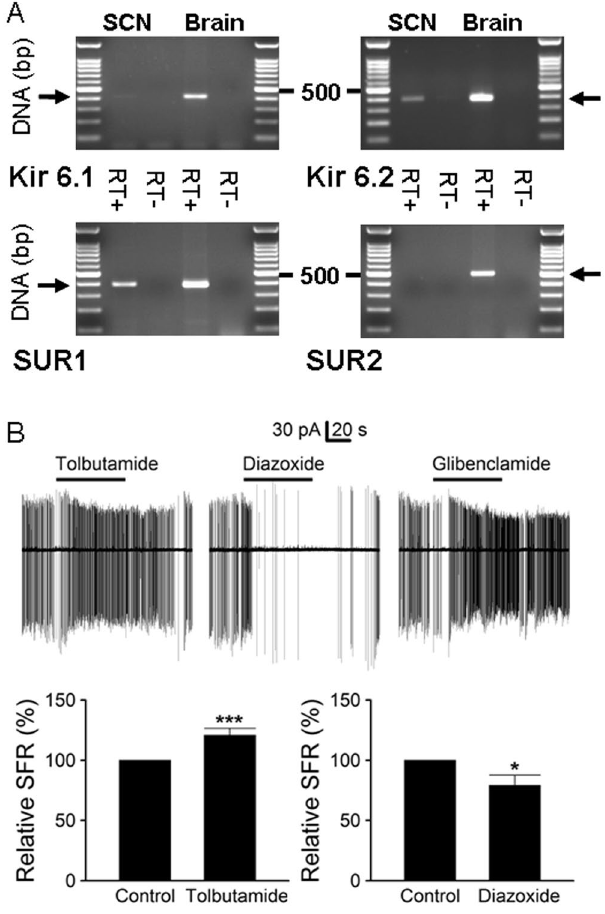
Figure 1. Kir6.2/SUR1 combination of K ATP channels in the SCN neurones. ( A ) RT-PCR analysis indicating the expression of mRNA for pore-forming Kir6.2 and sulfonylurea subunits 1 in the SCN. Positive controls were performed using cDNA from rat brain. The expected PCR product sizes for Kir6.1, Kir6.2, SUR1, and SUR2 were 411, 385, 388, and 501 bp, respectively. Negative controls were performed using RT products with omission of reverse transcriptase (RT-) to examine the contamination of genomic DNA. ( B ) Cell-attached recordings showing the effects of the sulfonylurea on spontaneous firing of the SCN neurones (ZT 4–15). Firing responses of a representative cell to 200 μ M tolbutamide (top left panel), 200 μ M diazoxide (top middle panel), and 0.1 μ M glibenclamide (top right panel). Note the lack of recovery of spontaneous firing after washout of glibenclamide. Daytime recordings (ZT 7). Bottom left panel: summary of experiments showing a moderate increase in firing rate by tolbutamide. Baseline spontaneous firing rate: 2.7 ± 0.3 Hz ( n = 50). Bottom right panel: summary of experiments showing a decrease in firing rate by diazoxide. Baseline spontaneous firing rate: 3.0 ± 0.3 Hz ( n = 17). * P < 0.05, *** P <